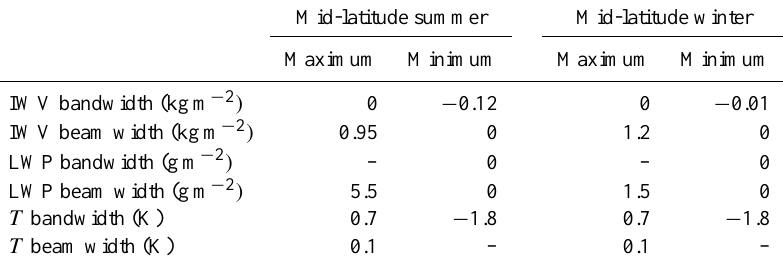
Table 4. Summary of retrieval errors associated to the different effects (bandwidth (100–1000MHz), beam width (0.5–10 ◦ )) for each retrieval that are below any instrument measurement capability. The IWV and LWP values are mapped to zenith, while the temperature is